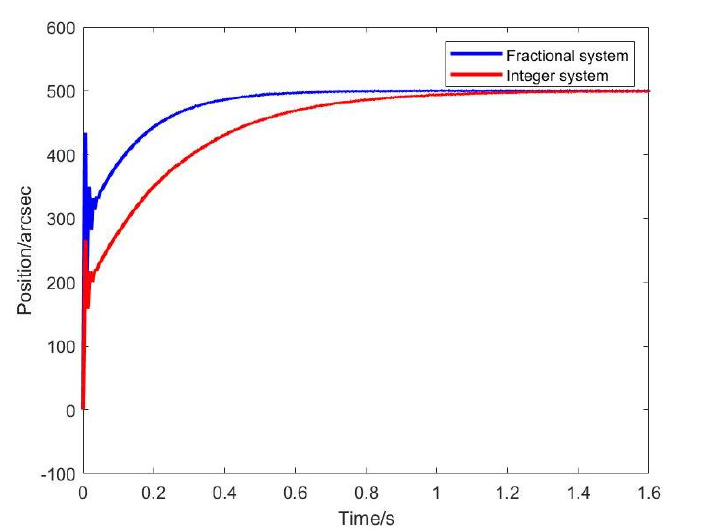
Figure 13. ETS responses using controllers based on fractional/integer-order